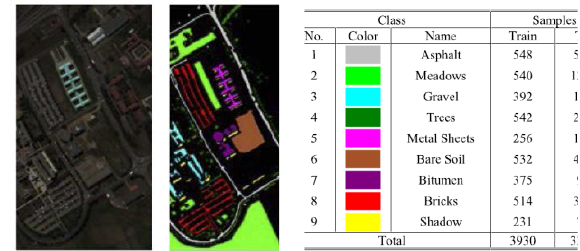
Figure 2: Pavia University Data Set and number of train and test samples